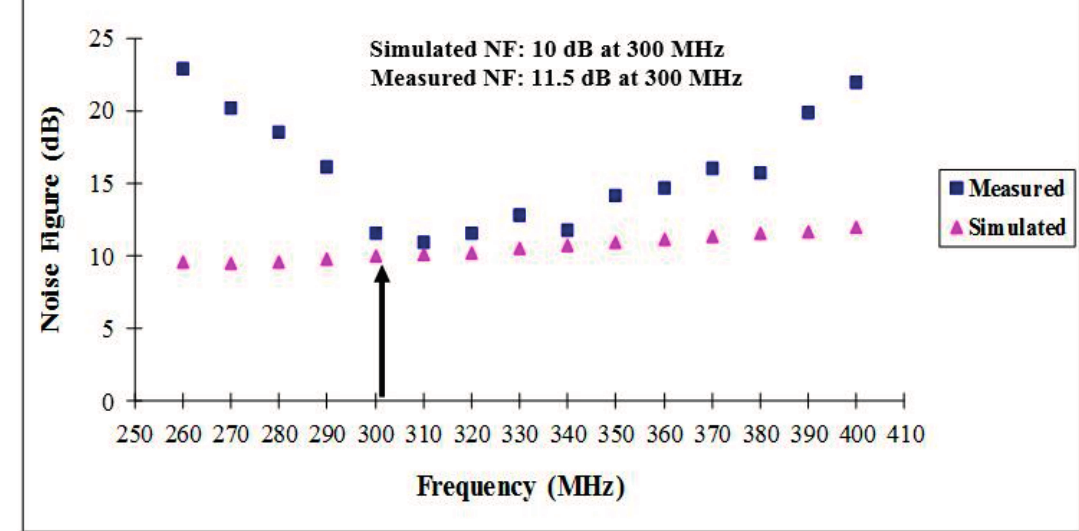
Figure 7. Noise figure of the receiver front-end.